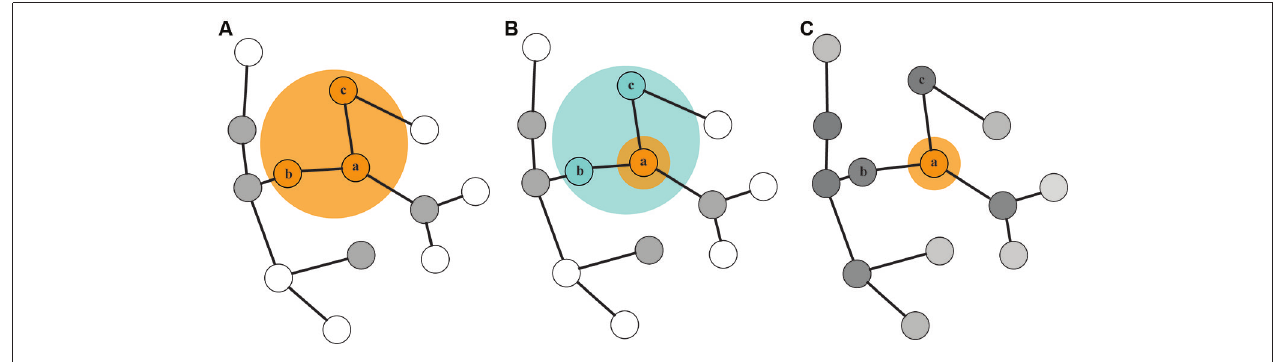
from a highly activated region of direct access (containing items b and c ; we refer to this region of direct access as the “state of direct access” (SDA) in this manuscript). After information becomes deprioritized, it transitions to a state of activated LTM. McElree’s (1998) model (C) posits a single-item FoA (containing item a ), with all other memory in a common state with smoothly varying levels of memory